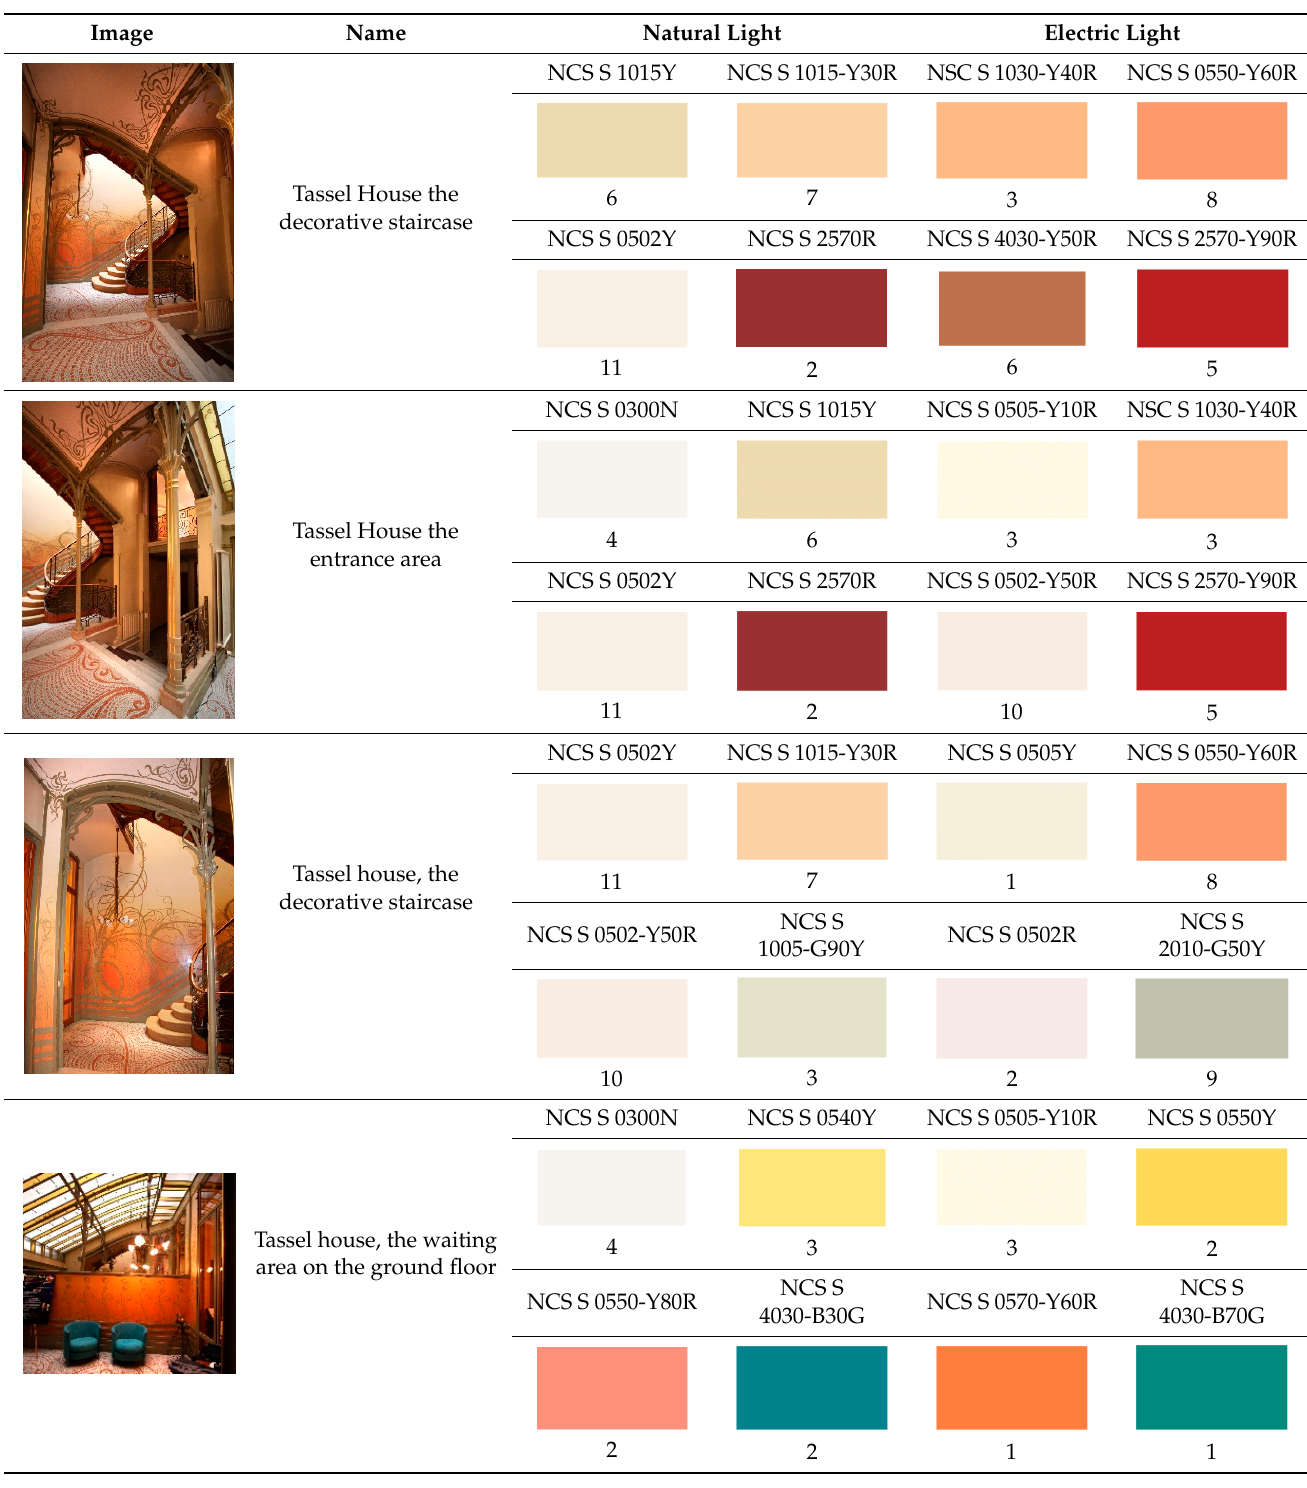
Table A5. The colors of the interiors of the examined buildings designed by Victor Horta.